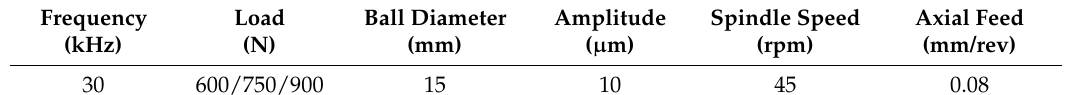
Table 2. MUSR (multi-pass ultrasonic surface rolling) processing parameters.